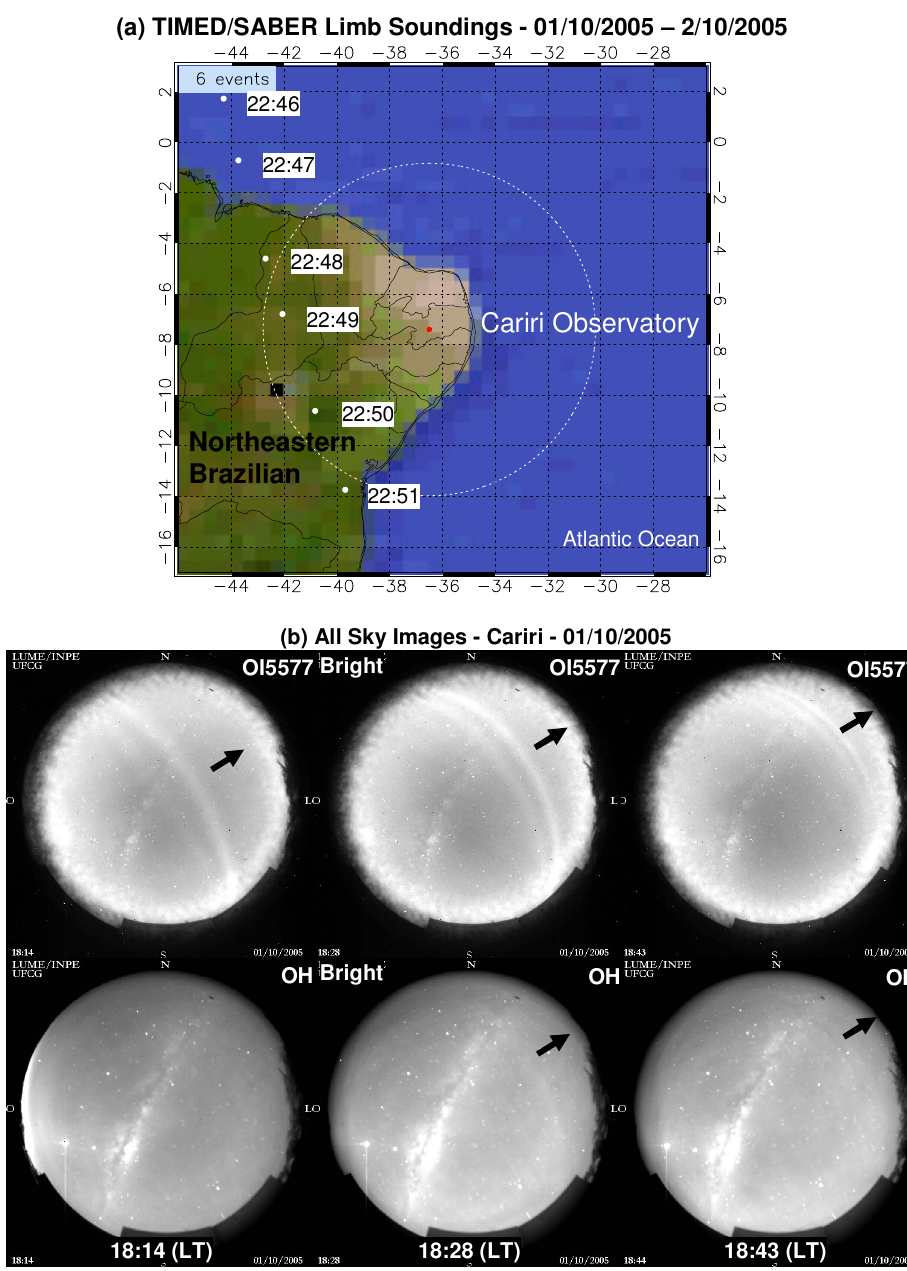
Fig. 1. (a) (top) TIMED/SABER soundings (tangent points represented by white dots) over the northeastern of Brazil between 22:00 and 24:00(LT). The red dot marks the location of S˜ao Jo˜ao do Cariri and the dotted circle represents the area recorded by imager at airglow altitude. (b) Successive images of the all-sky OI5577 (top) and OH (bottom) airglow emission images showing the mesospheric front, observed on the night of 1 October 2005, during the SpreadFEx campaign. The arrows indicate the propagation direction of the wave